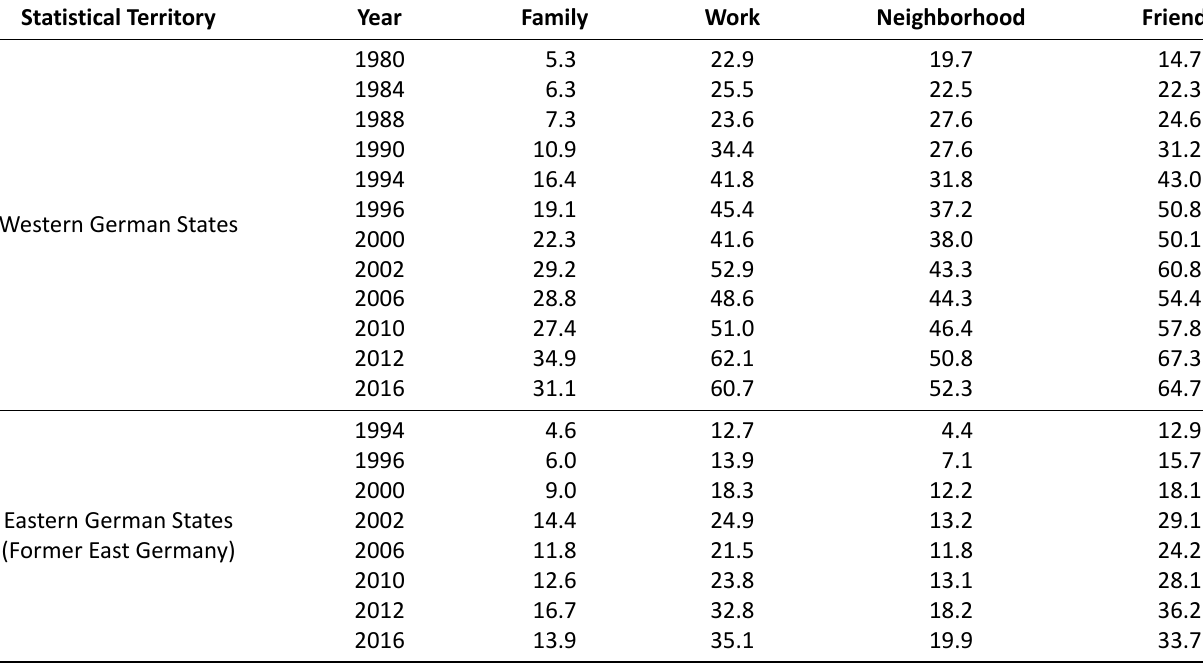
Table 3. Personal contact with foreigners residing in Germany in various areas of life (in percent). Source: GESIS (2019a). Statistical